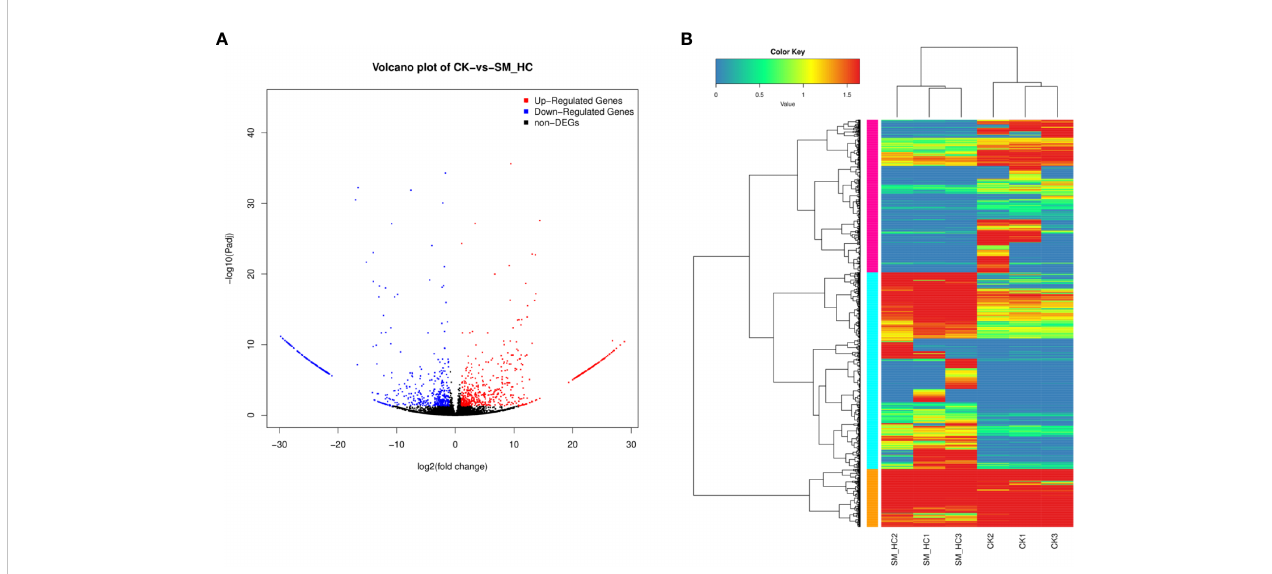
FIGURE 5 Overview of DEGs. (A) Comparison of DEGs between the CK library and SM_HC library. Red spots represent signifcantly upregulated genes and blue spots represent signi fi cantly downregulated genes. Black spots indicate no signi fi cant diferences in gene expression. (B) Heatmaps illustrating diferences in normalized log signal intensity for the identi fi ed H cunea genes. S. marcescens treatment groups were labeled as SM_HC1, SM_HC2 and SM_HC3, and control groups were labeled as CK1, CK2 and CK3. Red indicates genes expressed at high levels and blue indicates genes expressed at low levels. The colors from blue to red indicate gradually increasing expression.